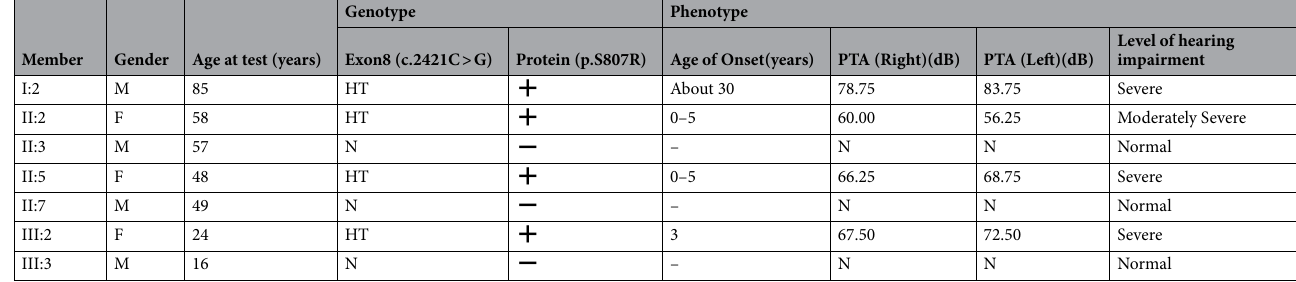
Table 1. Phenotypes and genotypes of the family subjects. F: female, M: male, mutation, ➖ : no mutation,